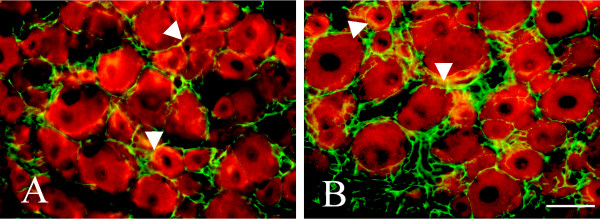
Localization of BDNF in the DRG after hind-paw incision. Representative double immunofluorescence labeling of BDNF (red) with S-100 (Green) (Figure 4A) and GFAP (green) (Figure 4B) in the ipsilateral DRG after hind-paw incision for 6 hours; arrow indicate double labeling. Bar = 50 μm.